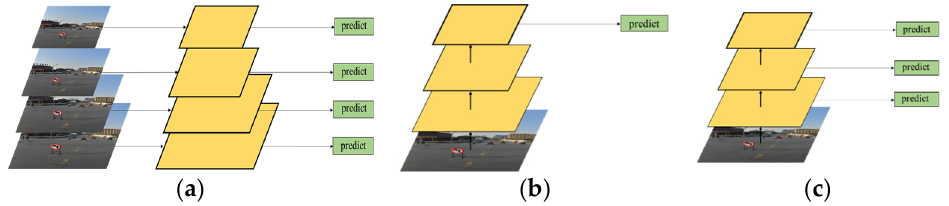
Figure 3. Common feature image pyramids. ( a ) different sizes; ( b ) semantic information; ( c ) fusion sizes and semantic information.